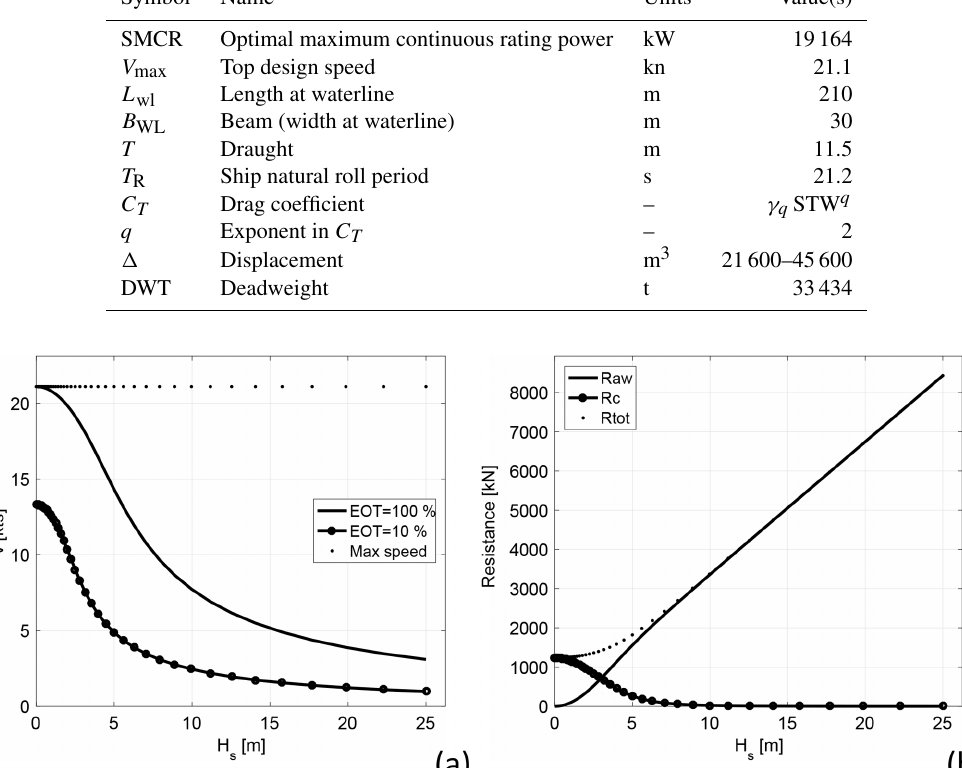
Figure 4. Vessel response functions for the parameters given in Table 4. (a) STW at a constant engine throttle vs. significant wave height H s . Both EOT = 100% (solid line) and EOT = 10% (line and dots) are displayed. (b) Calm water R c , wave-added resistance R aw , and their sum R tot as functions of H s